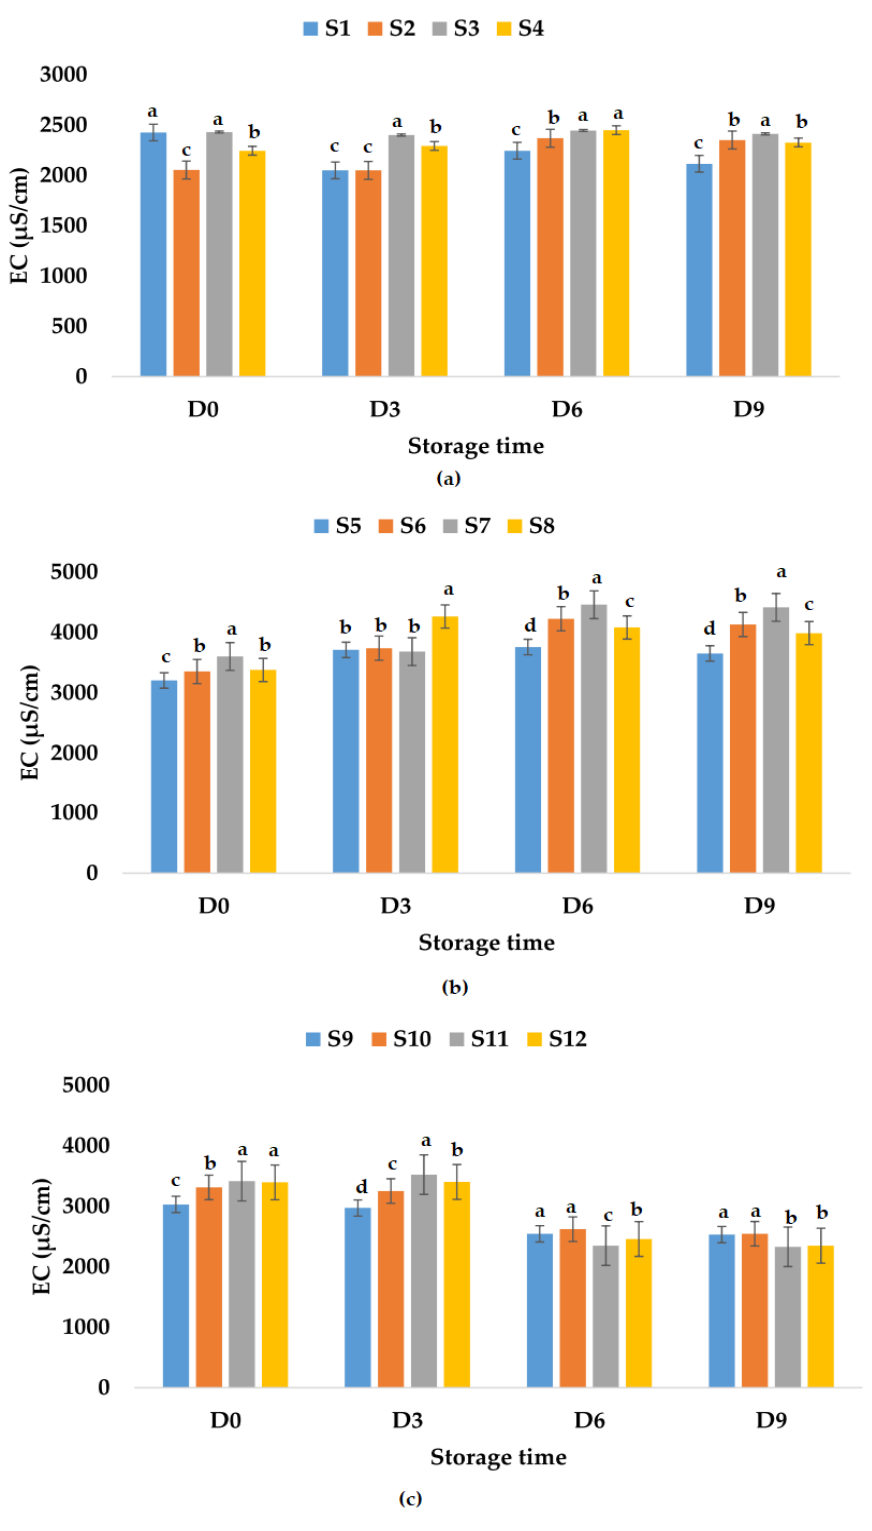
Figure 8. Variation in EC ( µ S/cm) of juice samples during the storage period (D-day) at room temperature (20 ◦ C): ( a ) apple juice samples (S1, S2, S3, S4); ( b ) apple and pumpkin juice samples (S5, S6, S7, S8); ( c ) apple and pomegranate juice samples (S9, S10, S11, S12). Means with different lowercase letter indicate the significant differences ( p < 0.05) among the samples and were performed separately for each day of